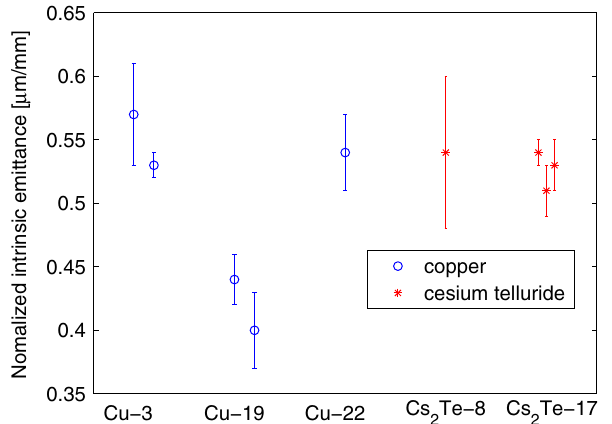
FIG. 5. Measured normalized intrinsic emittances for the five cathodes studied at the SwissFEL Injector